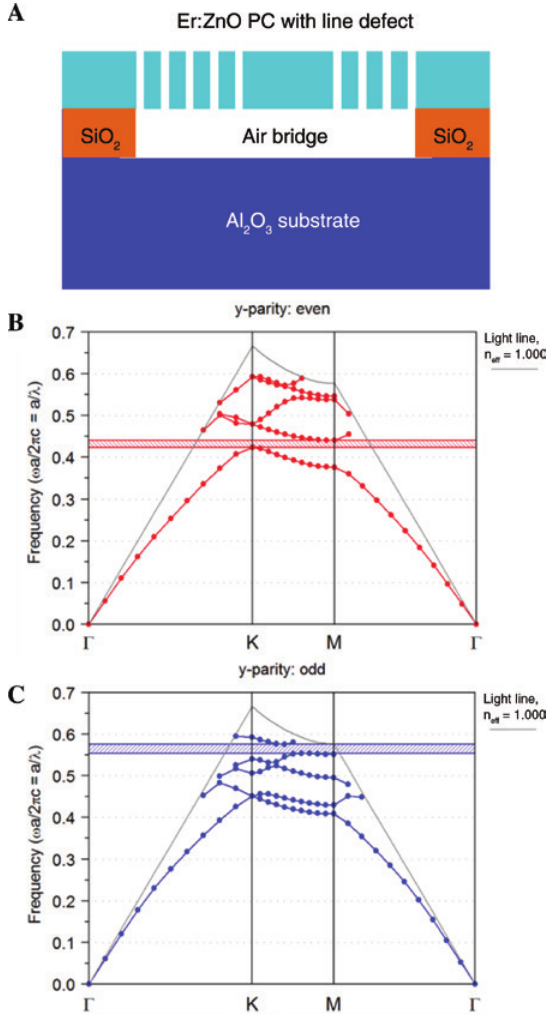
Figure 7: (A) Cross-section of the air bridge PC in Er:ZnO film depos- ited on SiO -Al O substrate, which can be obtained by removing 2 2 3 SiO using chemical selective etching in the sandwich structure. 2 Band structures of the air bridge Er:ZnO PC. (B) Even mode. (C) Odd